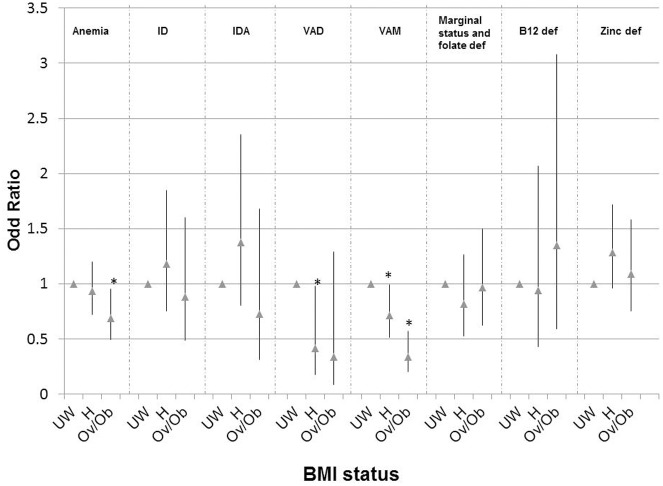
Unadjusted odds ratios for overweight/obesity for Vietnamese women of reproductive age.Note: UW: underweight women; H: healthy women; Ov/Ob: overweight or obese women; ID: iron deficiency; IDA: Iron deficiency anemia; VAD: vitamin A deficiency; VAM: vitamin A marginal status; def: deficiency.